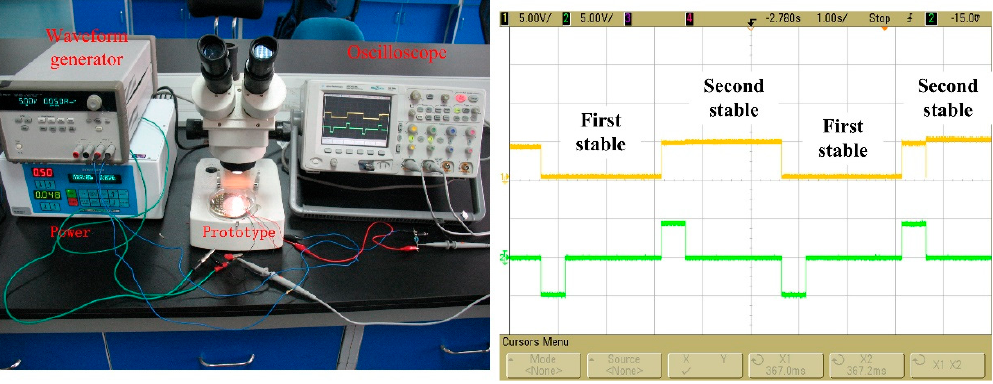
Figure 8. Bistable mechanism of the prototype.